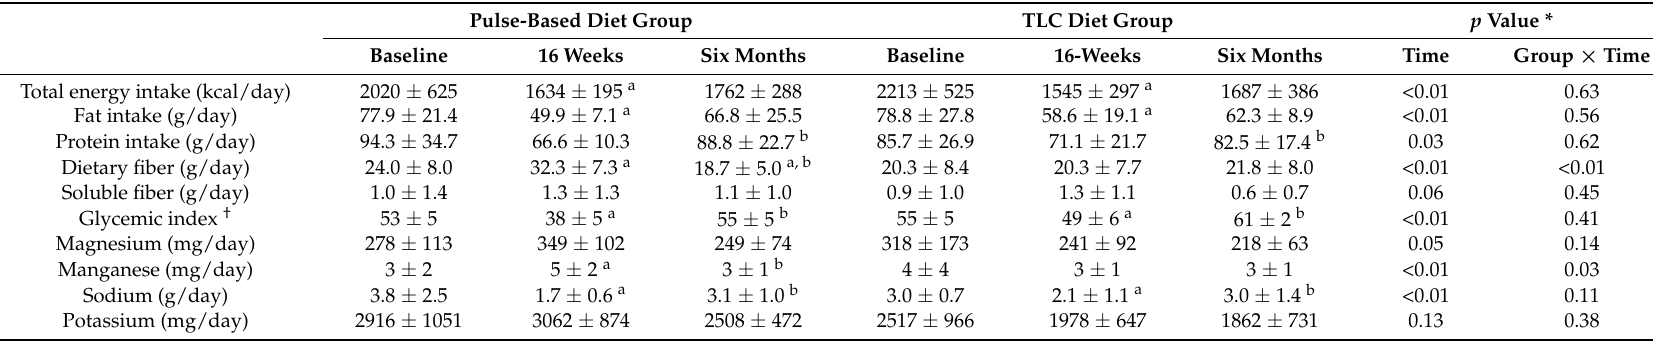
Table 6. Dietary intakes of women who completed the six-month follow up phase of the study at baseline, 16 weeks, and six months post-intervention. Pulse-Based Diet Group TLC Diet Group p Value *